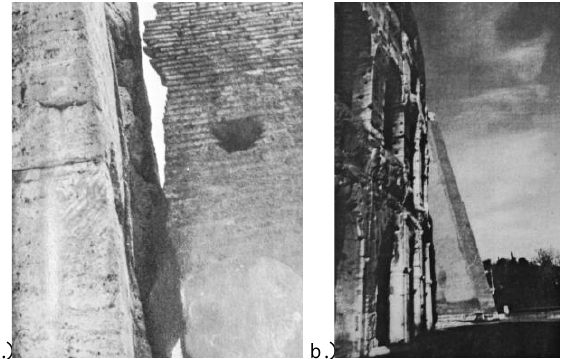
Figure 6. a.) Detachment of the travertine columns from the radial walls. b.) Out-of-plane behaviour of the façade from the